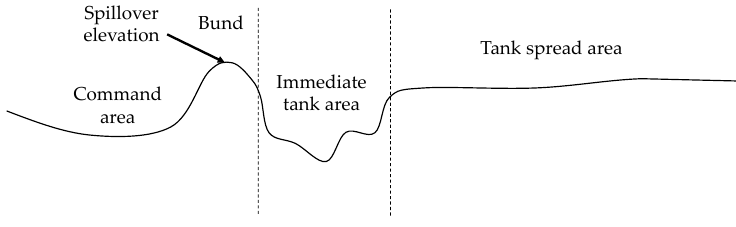
Figure 2. Typical tank geometry, adapted from [31]. The tank initially fills in the immediate tank area, which is adjacent to the tank bund. The tank spread area extends beyond the main depression of the tank; this region is often farmed land and floods when water levels are